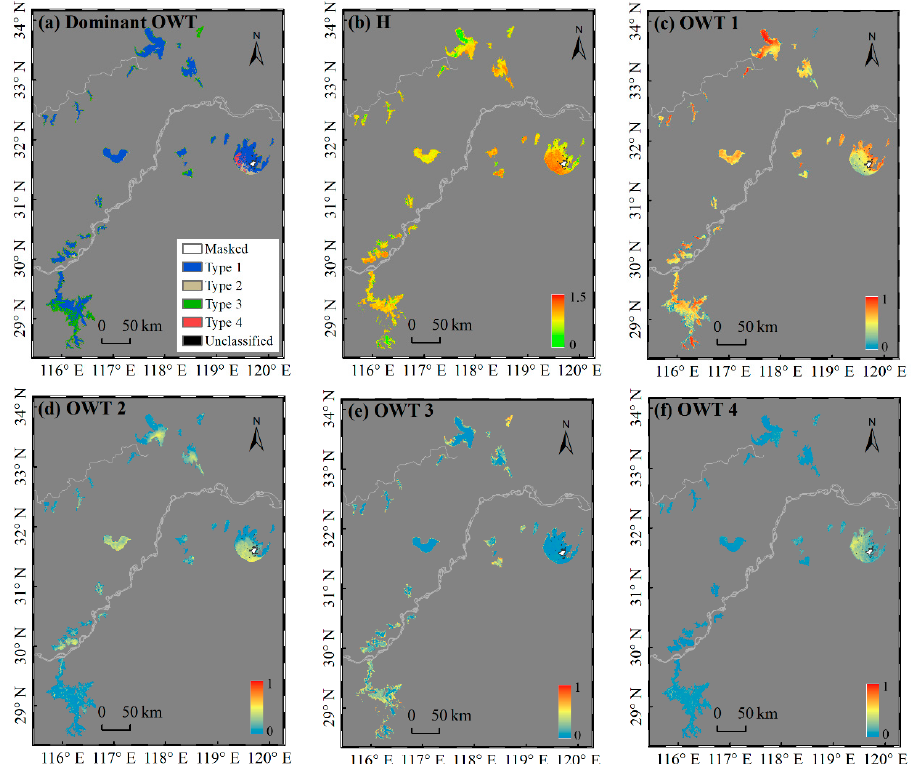
Figure 10. ( a ) Dominant OWTs of the lakes in the LYHR Basin in 2017 (the class most frequently selected as the dominant class over the period); ( b ) Shannon index ( H ) computed from the frequency of the different OWTs of the lakes in the LYHR Basin in 2017. ( c – f ) The annual frequency of the different OWTs: ( c ) type 1, ( d ) type 2, ( e ) type 3, ( f ) type 4, associated with lakes in the LYHR basin in 2017.